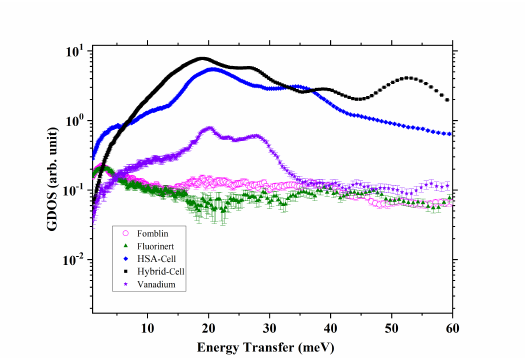
Fig. 4. The pressure calibration curve for the HSA-Cell.